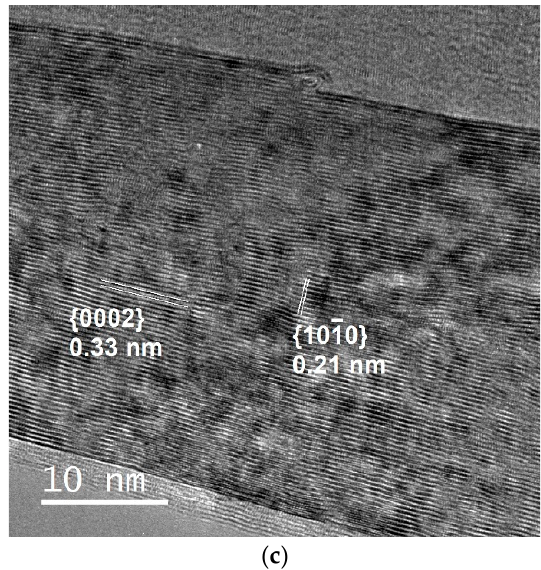
Figure 4. ( a ) Low- and ( b ) high-magnification ECNF TEM images and ( c ) lattice-resolved HRTEM images with polycrystalline carbon material and d-spacing between adjacent (002) and ~0.33 nm lattice planes.